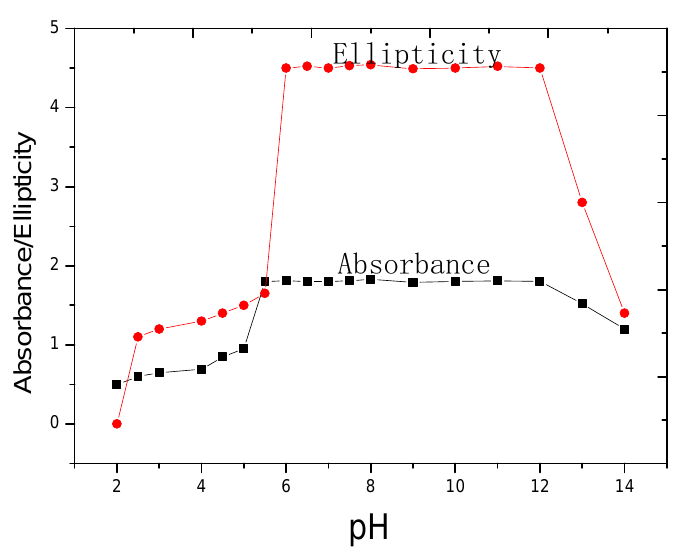
Figure 4. Dependence of UV and CD intensities on pH.Stock solutions containing Fe meso- tetra( α , α , α , α - o -phenylacetamidophenyl) porphyrin (10 -6 M) in 0.1 M PBS (pH 6.0), were prepared with excess of MAb 1F2 at 20 °C.The pH was changed by addition of a minimum amount of aqueous NaOH or HCl.